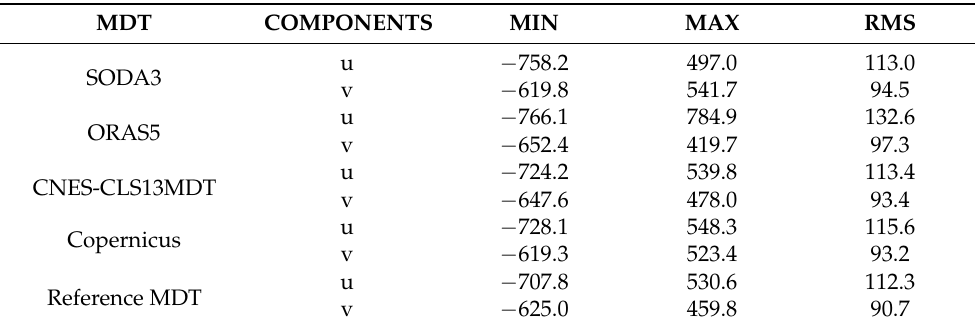
Table 4. Statistics of the differences in the geostrophic velocities between the buoy data and the MDT models (units: mm/s).